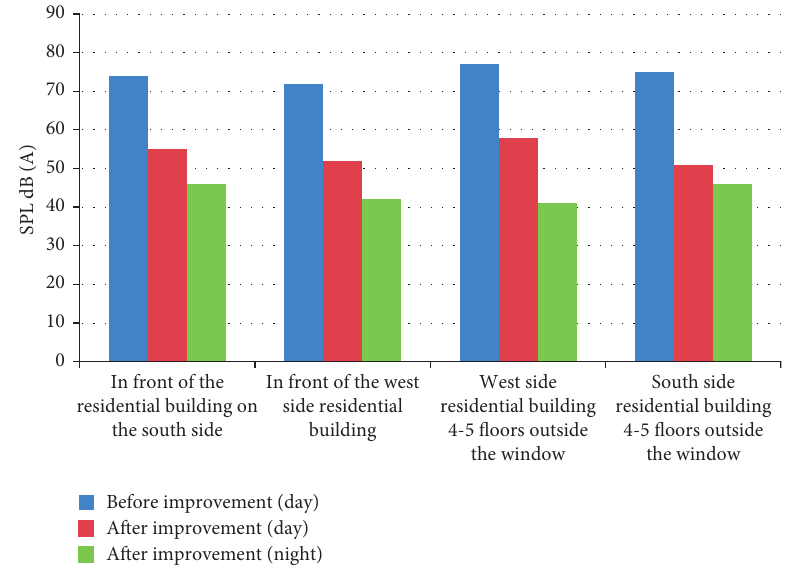
Figure 4: Sound pressure levels of the noise outside the window of the building before and after